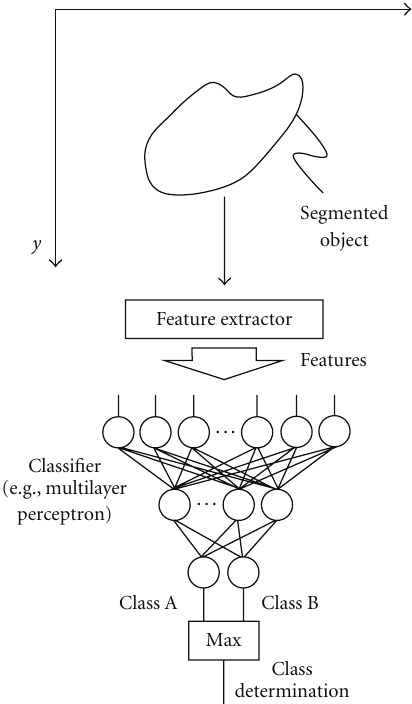
Figure 5: Standard classifier approach to classification of an object (i.e., feature-based ML). Features (e.g., contrast, e ff ective diameter, and circularity) are extracted from a segmented object in an